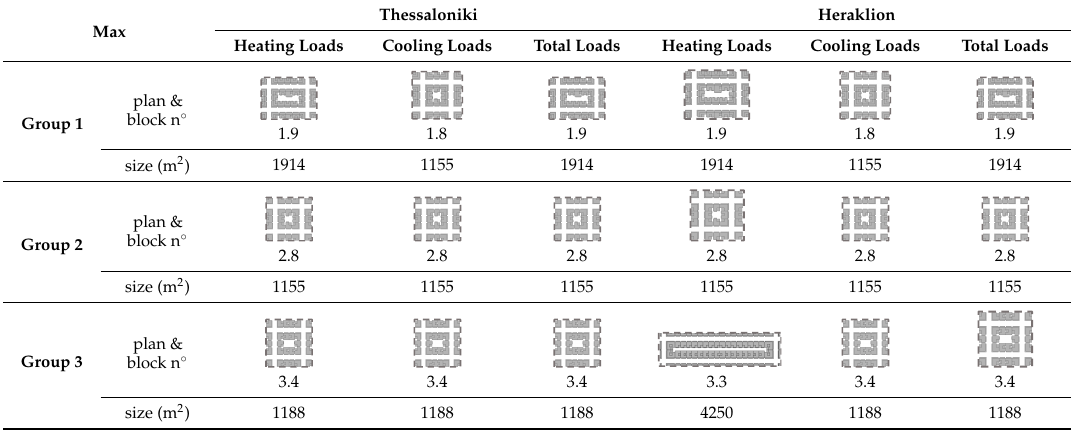
Table 6. Urban blocks presenting the maximum values for heating cooling and total load demand in each group for the two examined cities.